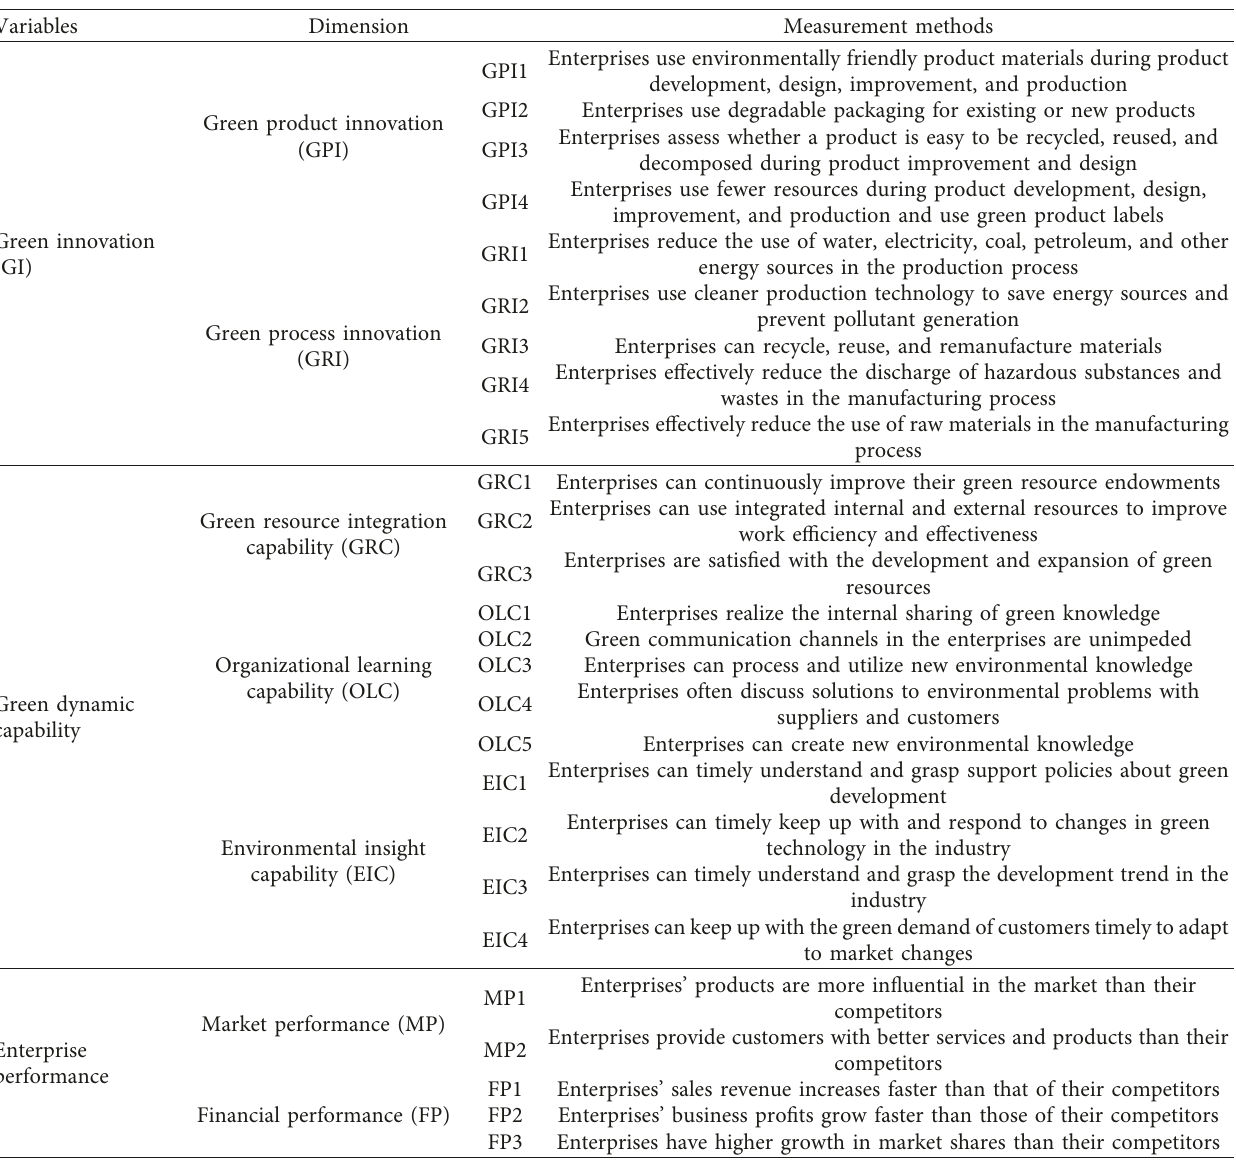
Table 3: Construct and survey items.